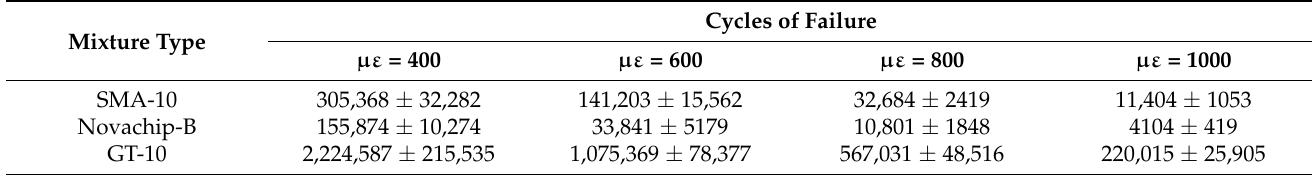
Figure 8. Results of four points bending fatigue test. Table 7. Results of four points bending fatigue